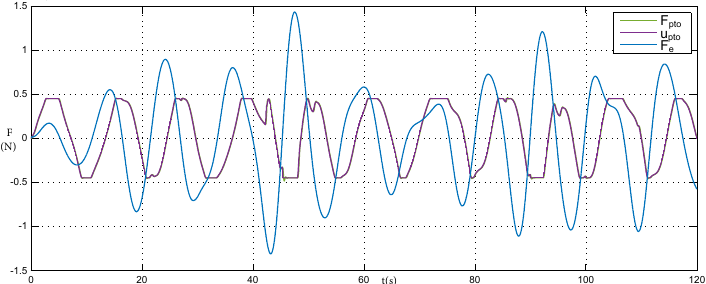
Figure 10. Wave force, force setpoint demanded and real force produced by the PTO, by applying the MPC 5 to the model (15), which has an added uncertainty to the hydrostatic restoring coefficient of